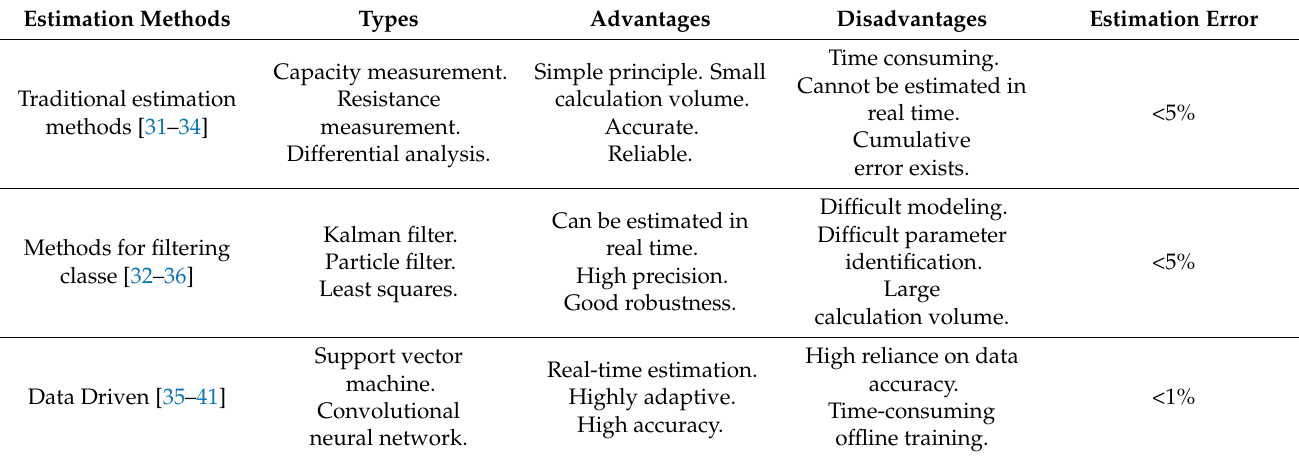
Table 3. Advantages and disadvantages of SOH-estimation methods for Li-ion batteries.